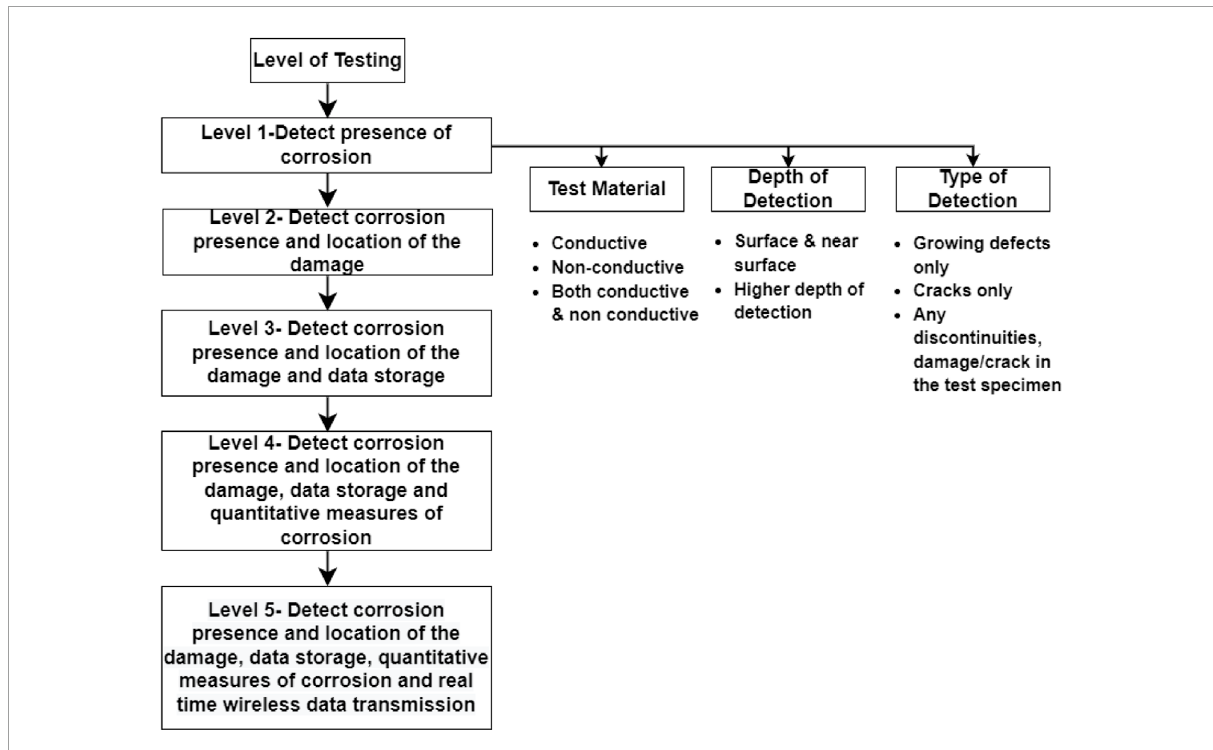
FIGURE 2 Levels of complexity in corrosion monitoring